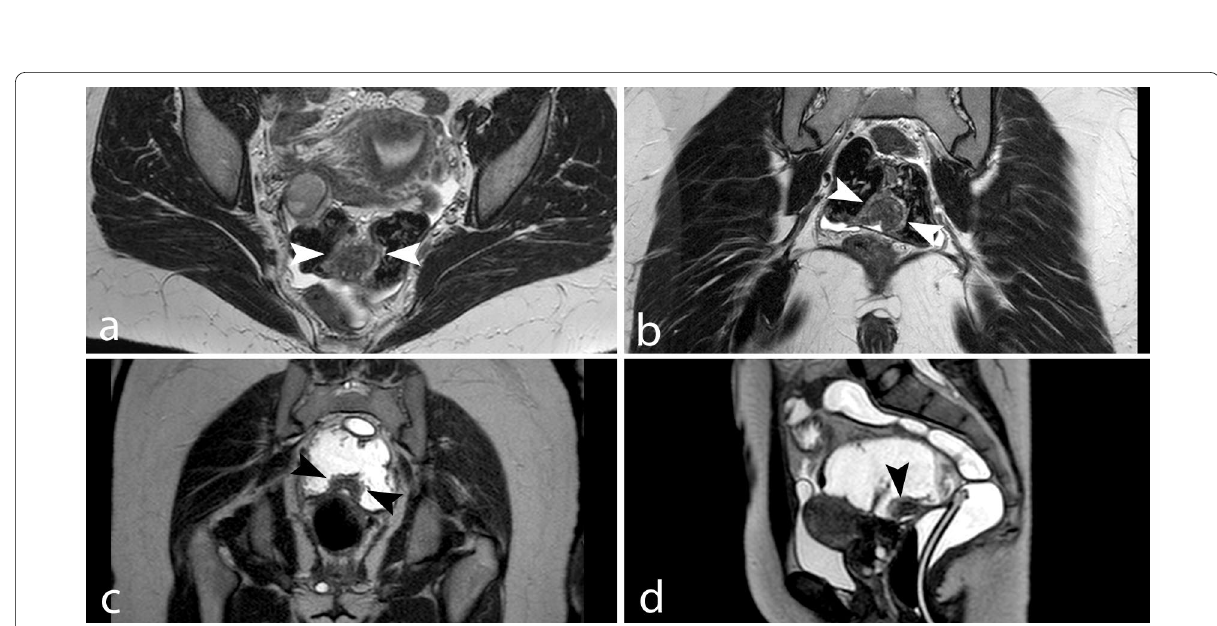
Fig. 9 DIE with cecal infiltration. TSE T2w axial ( a ) and coronal ( b ) images, SSFSE T2 MR-colonography coronal ( c ) and sagittal ( d ) images. A large DIE nodule with a mushroom shape (arrowheads) infiltrates the cecum which has a pelvic position in the pouch of